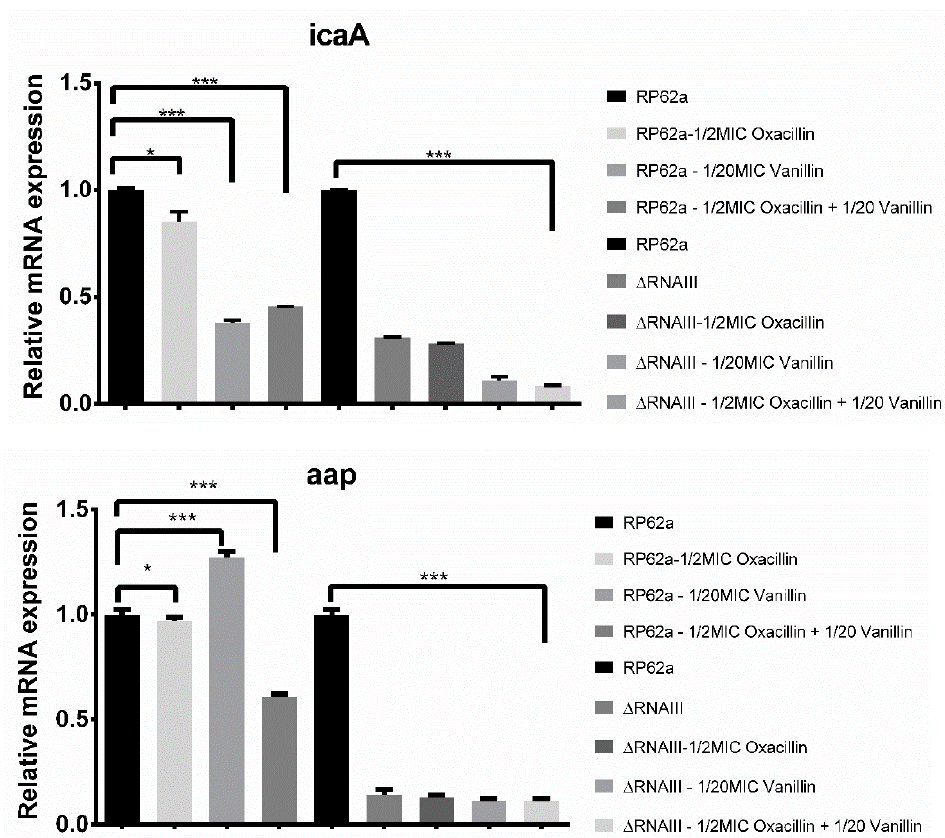
Figure 6. Real-time qPCR analysis of RNAIII biofilm genes aap and icaA . For both genes, relative mRNA expression was decreased compared to the control. As a control, a housekeeping gene for 16S rRNA and unaffected culture were used (* p < 0.01, *** p < 0.0001). Different results were obtained when treated only with vanillin. Aap expression